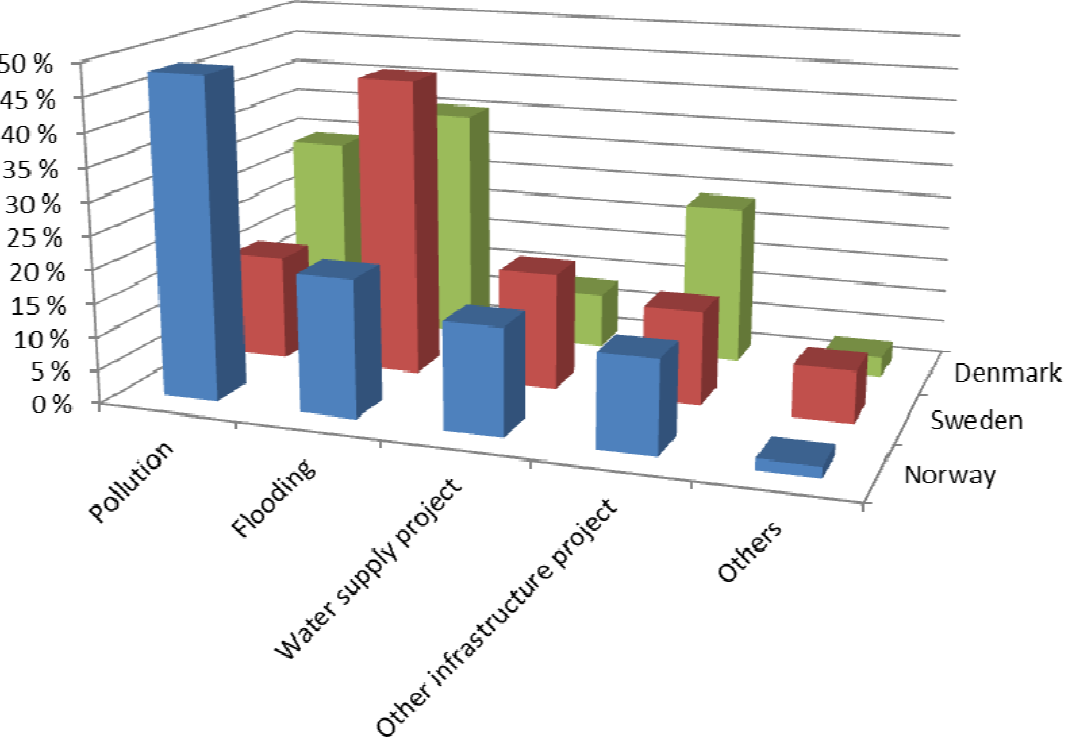
Figure 3. Causes triggering improvement projects in existing drainage and sewerage systems in the largest Scandinavian cities in